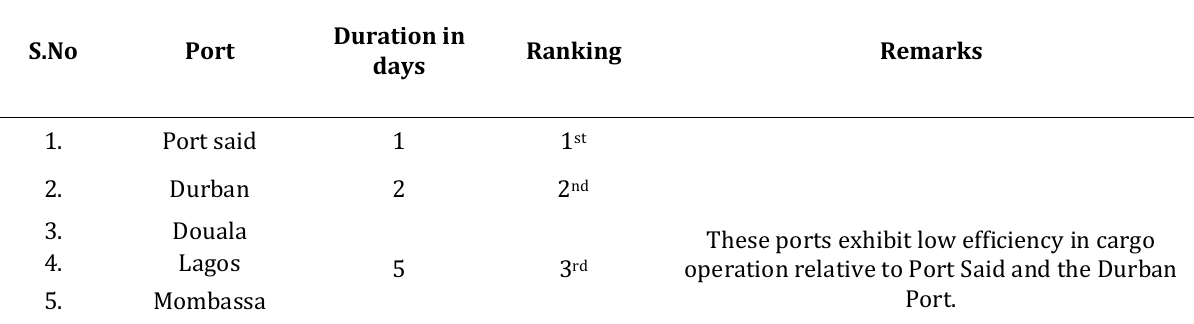
Table 4.2: Operational Dwell Time in Port S.No